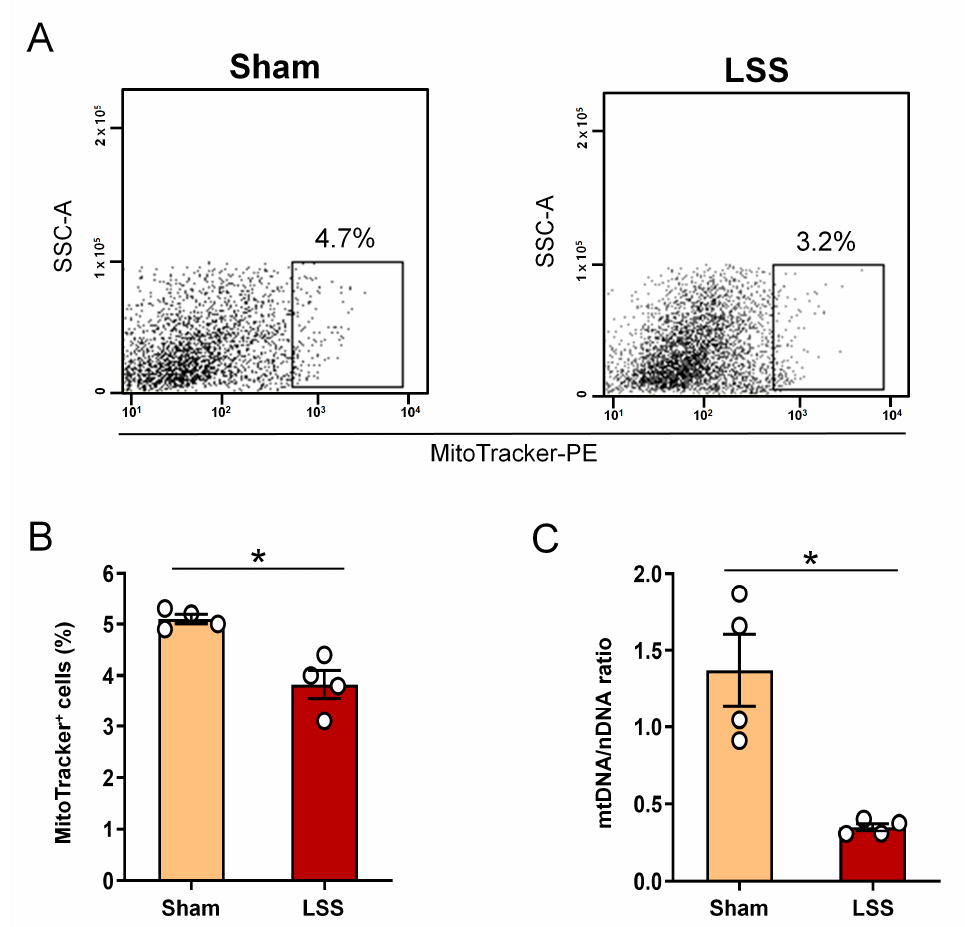
Figure 3. Analysis of extracellular mitochondrial mass within CSF after given LSS. ( A ) Representative flow cytometry dot blot of the MitoTracker Deep Red FM in sham and LSS groups. ( B ) Flow cytometric quantification of MitoTracker within the CSF in sham and LSS groups. ( C ) Real-time PCR based of mtDNA/nDNA ratio in sham and LSS groups. Data are expressed as the means ± SEM. Significant differences indicated as * p < 0.05 vs. the sham group were analyzed via unpaired t test with Welch’s correction.